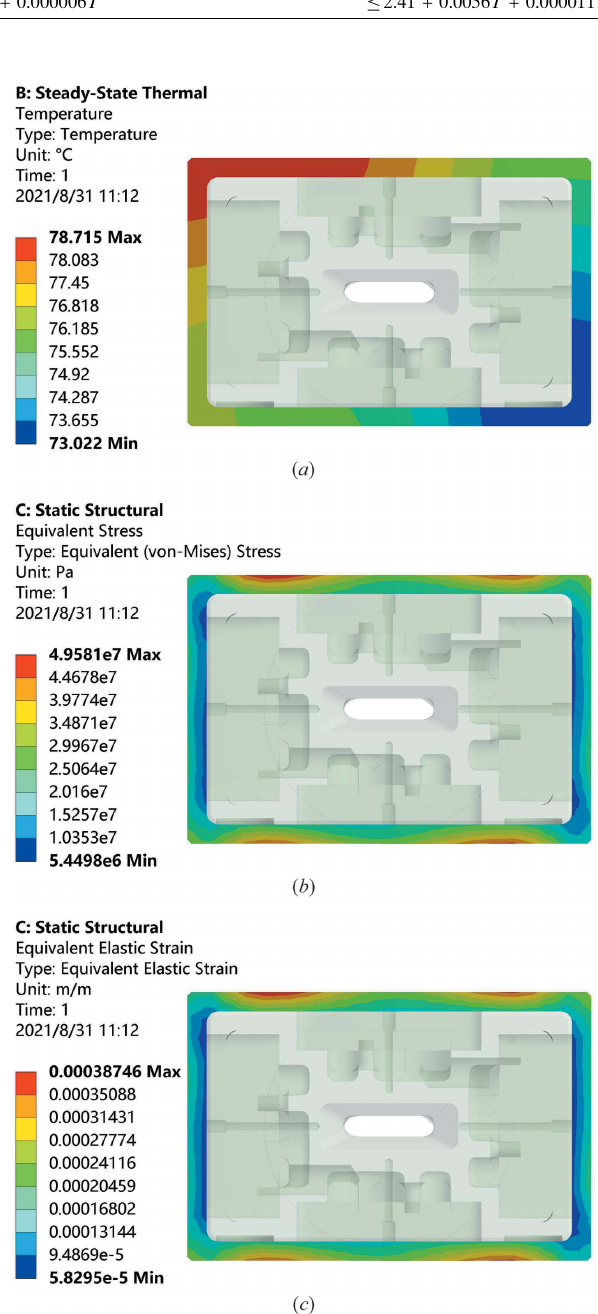
Figure 5 ( a ) Temperature, ( b ) equivalent stress and ( c ) equivalent strain distributions of the joint.